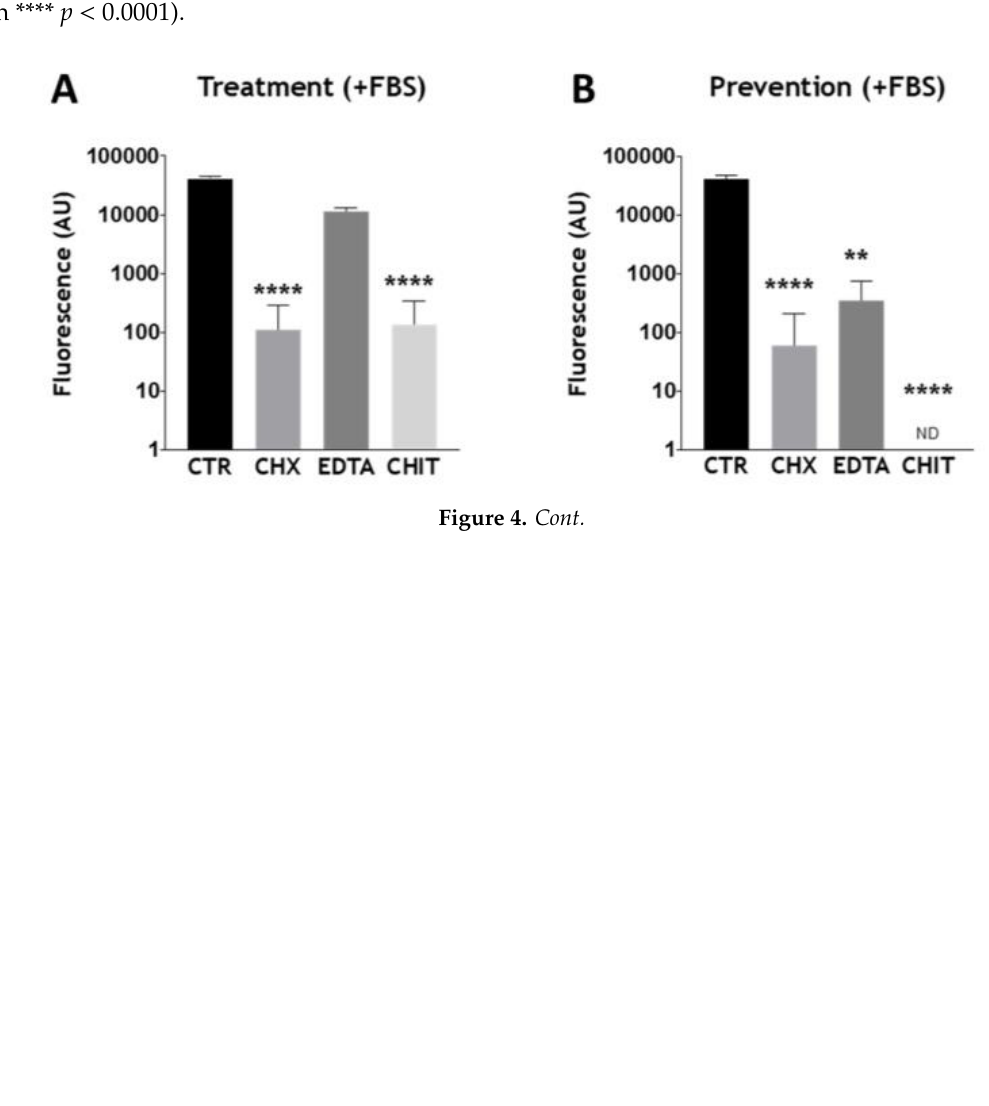
Figure 4. Assessing biofilm viability following treatment with conventional and novel endodontic therapies. Biofilms were grown in RPMI/THB + ( A , B ) or − ( C , D ) 10% FBS in 24-well plates for 24